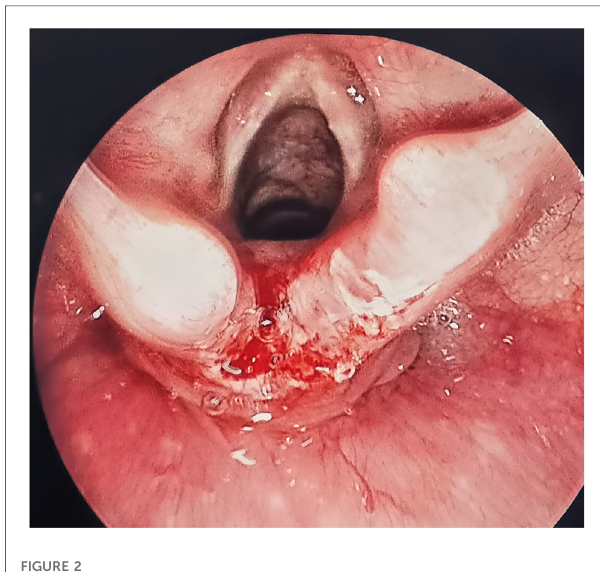
FIGURE 2 A fresh incision at the mucosal border of the cleft was